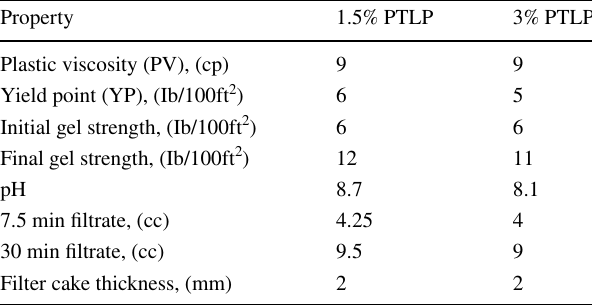
Table 2 The results of adding various concentrations of PTLP to